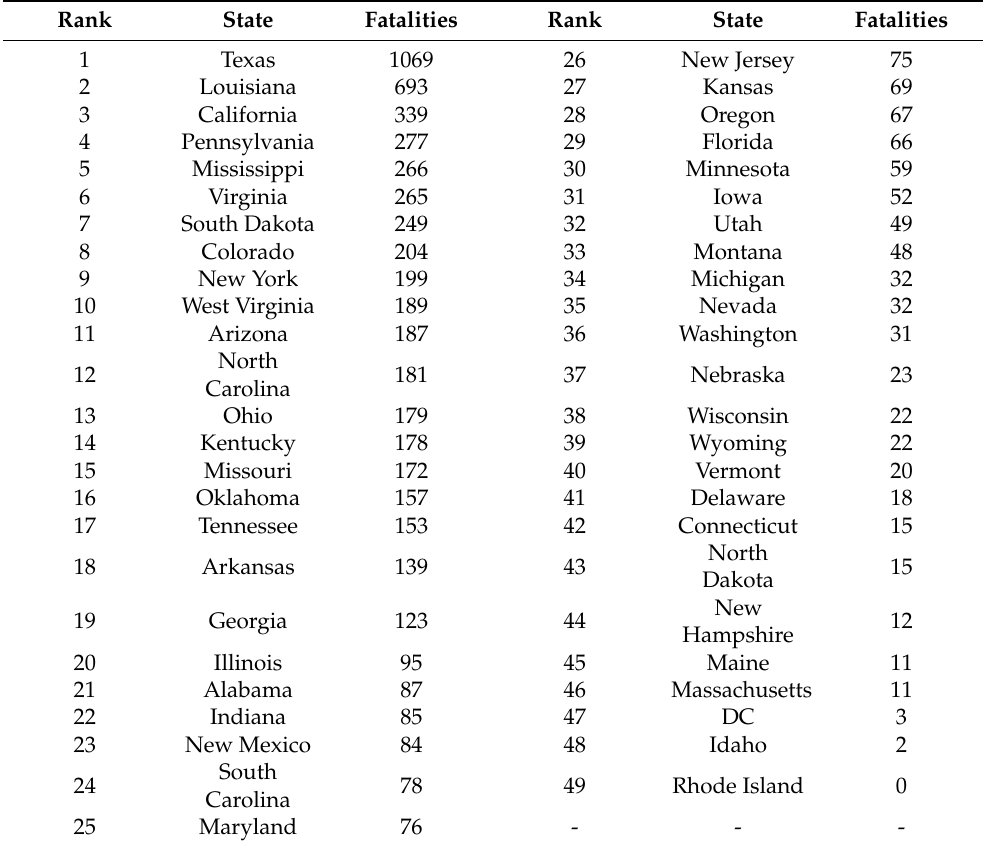
Table 1. Flood fatalities in the 48 contiguous states and District of Columbia (DC) and their ranks from